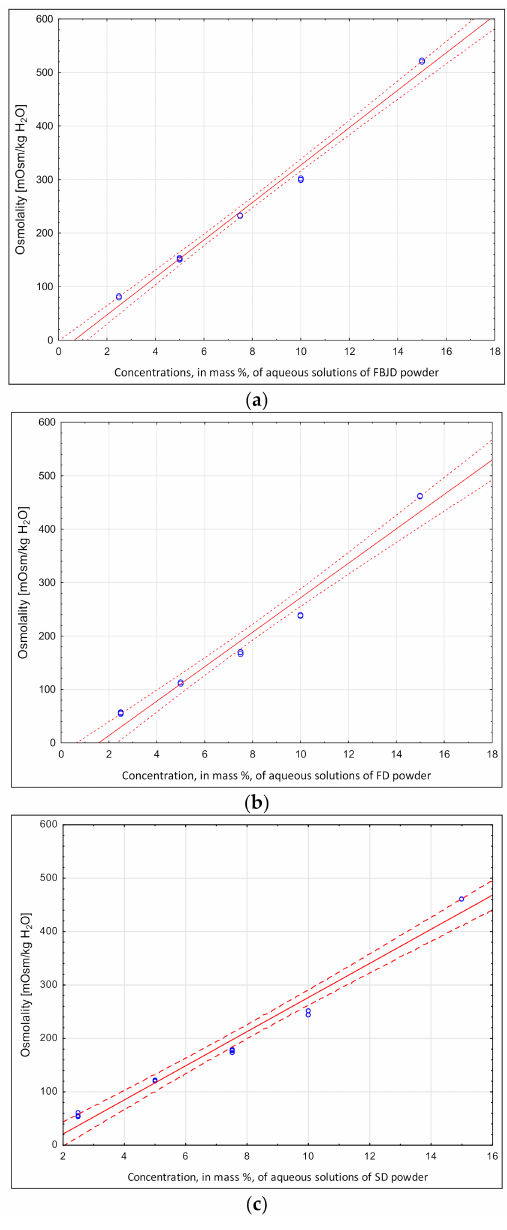
Figure 1. Raspberry powder osmolalities in aqueous solution. ( a ) FBJD powder: Osmolality = − 22.53 + 34.96 × Concentration (%); r 2 = 0.993. ( b ) FD powder: Osmolality = − 50.55 + 32.23 × Concentration (%); r 2 = 0.984. ( c ) SD powder: Osmolality = − 43.05 + 31.96 × Concentration (%); r 2 =